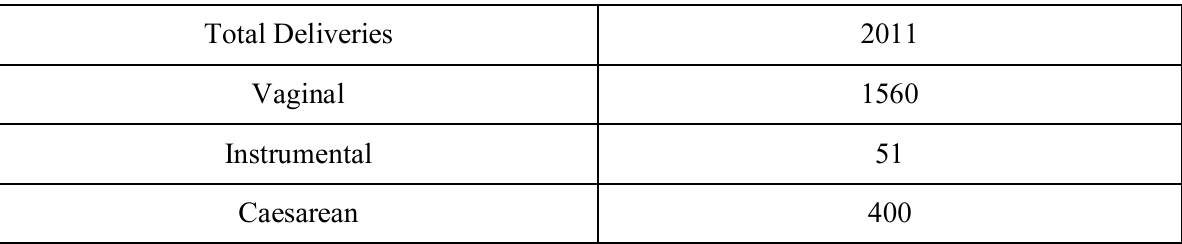
Table: 1: Incidence: